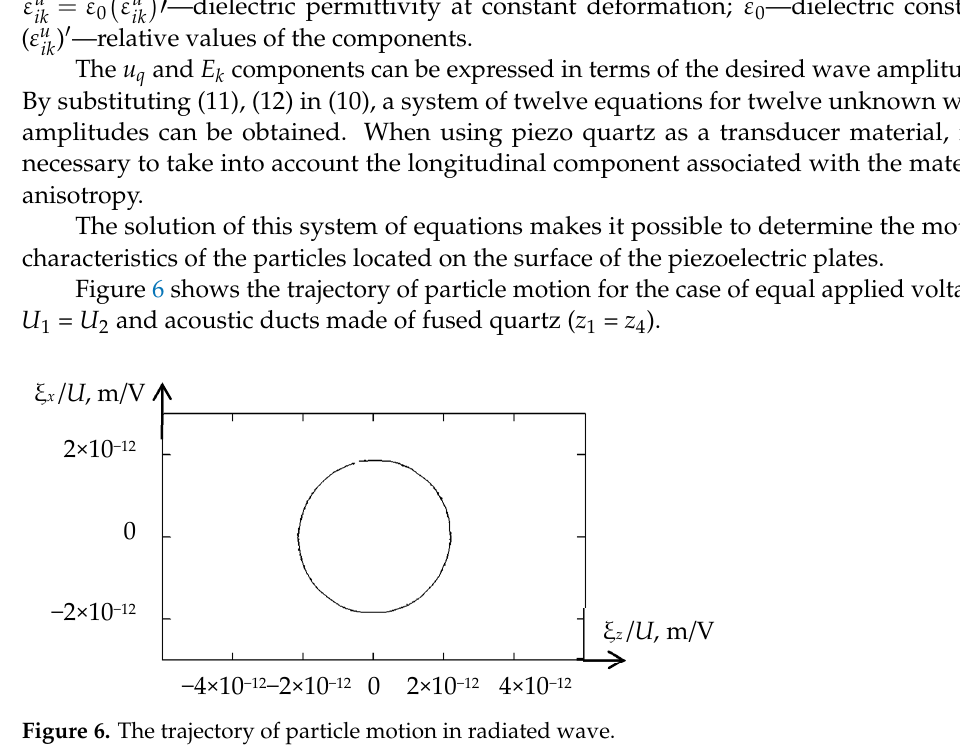
where λ and μ are the Lame’s elastic moduli.